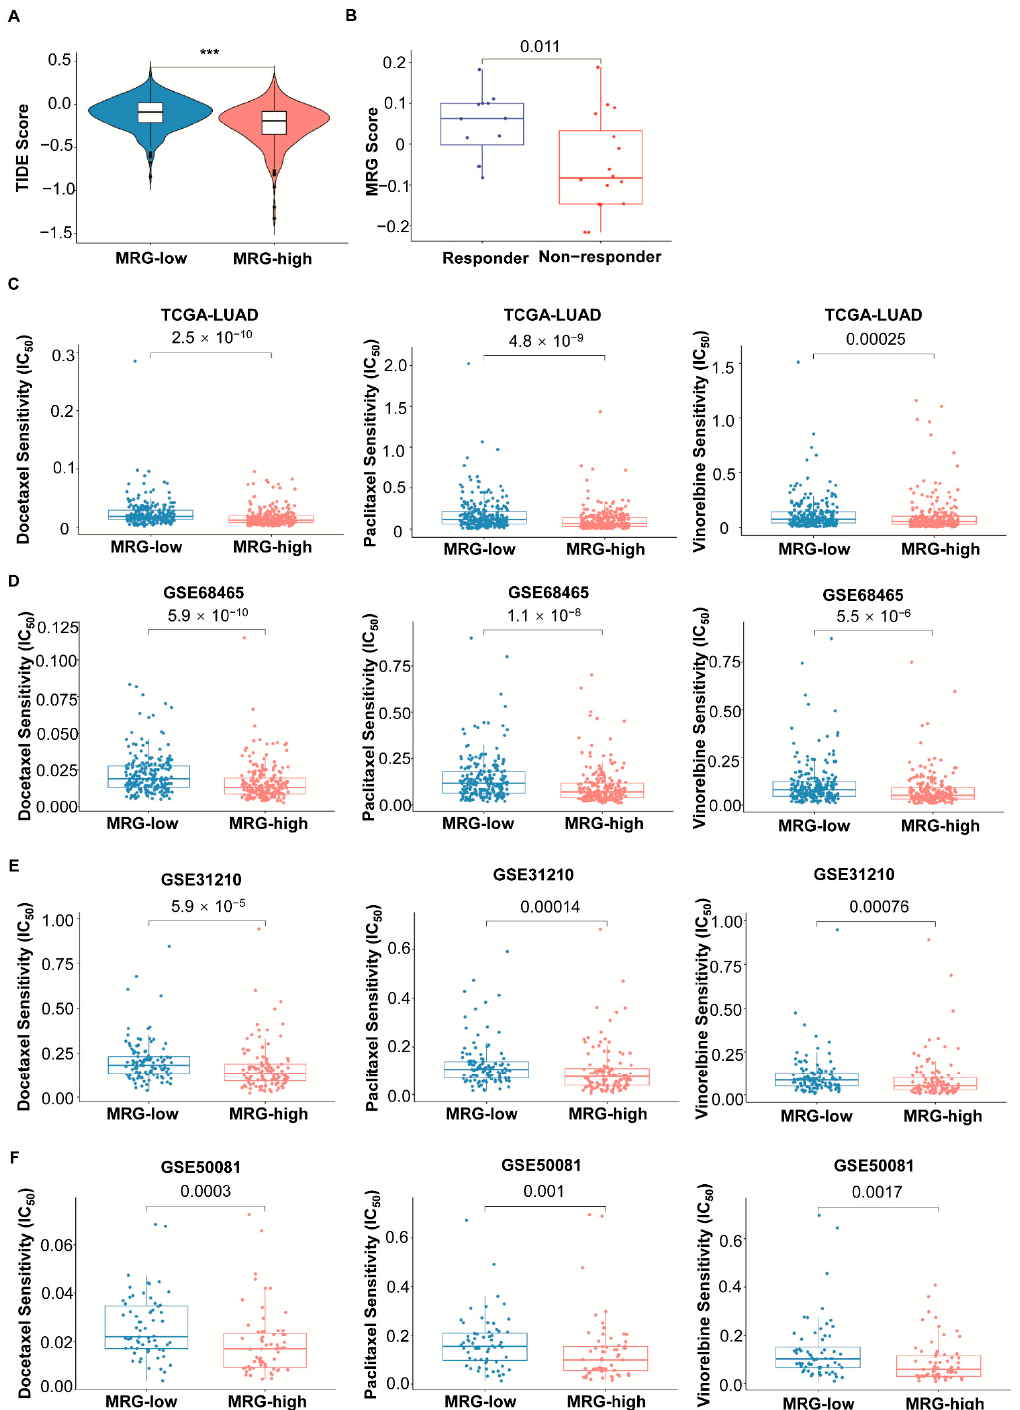
Figure 6. The prognostic value of MRG in patients with different therapies. ( A ) TIDE score in different MRG subgroups. Significant statistical differences between the two subgroups were assessed using the Wilcoxon test (***, p < 0.001). ( B ) MRG score of responder and non-responder of ICIs in LUAD patients. (GSE126044 ( n = 16) and GSE93157 ( n = 12)). Significant statistical differences between the two subgroups were assessed using the Wilcoxon test. p value is shown in the figure. ( C – F ) Response to chemotherapeutic agents in both MRG subgroups from TCGA ( n = 500), GSE68465 ( n = 442), GSE31210 ( n = 226), and GSE50081 ( n = 127), respectively. Significant statistical differences between the two subgroups were assessed using the Wilcoxon test. p value is shown in the